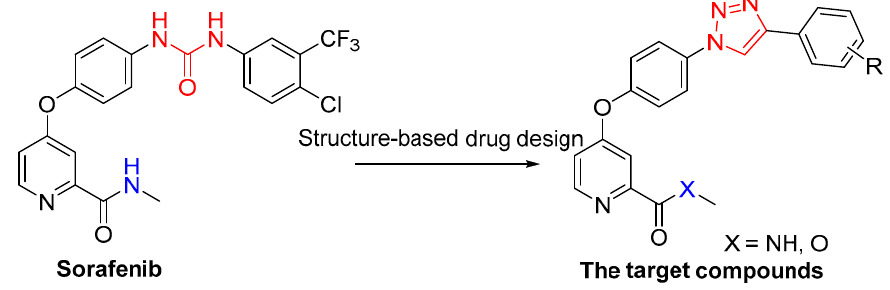
Figure 1. Design of novel sorafenib analogs.